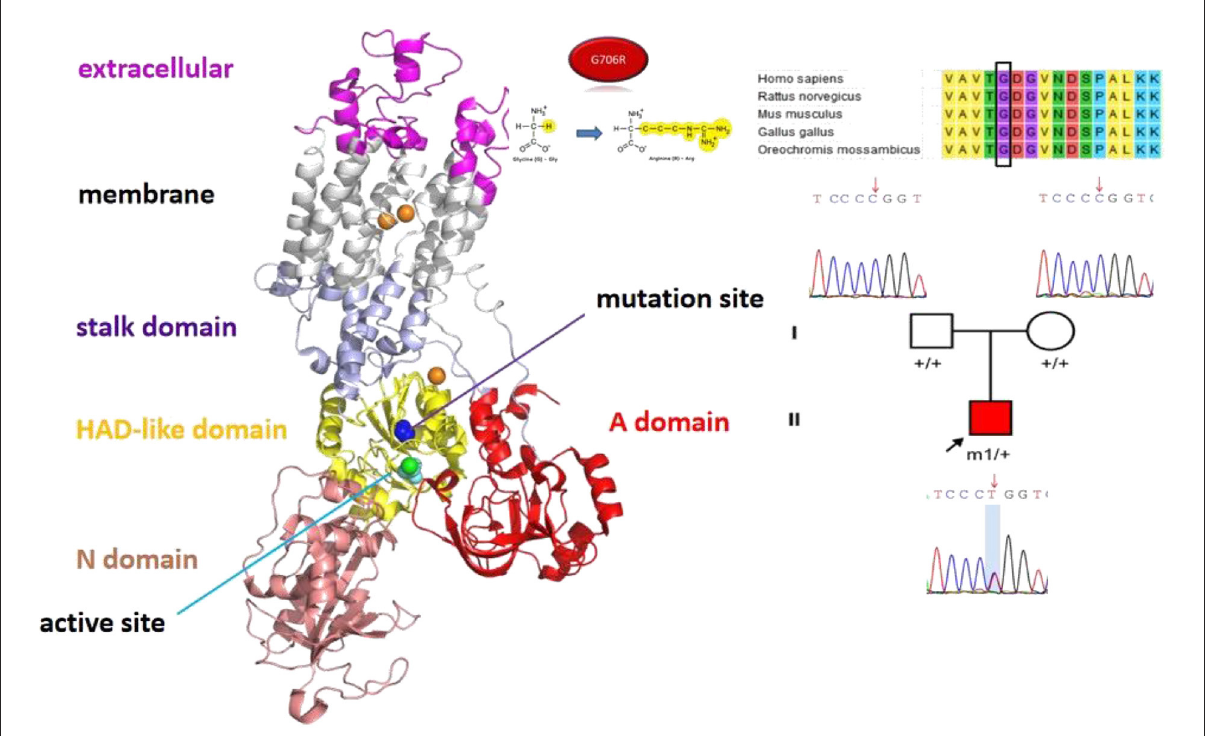
FIGURE4 The position of the mutation sites ATP1A3 p.G706R in the protein spatial